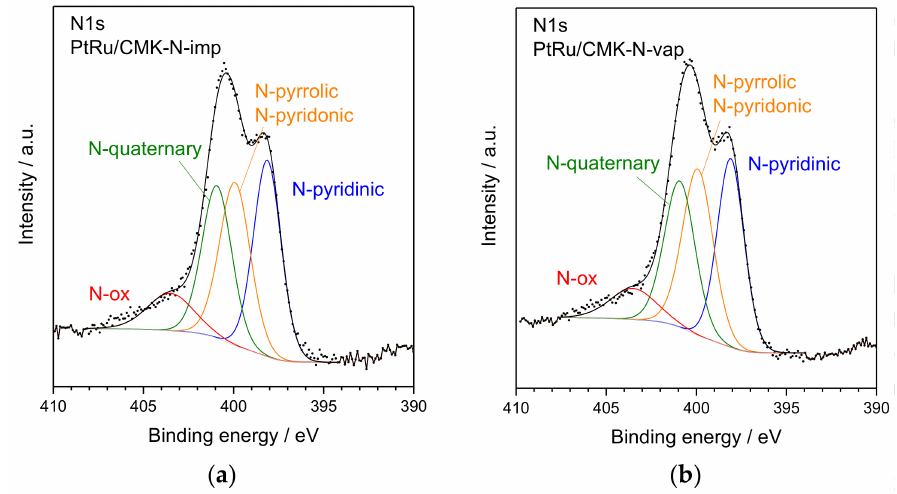
Figure 4. XPS high-resolution N1s spectra of: ( a ) PtRu/CMK-N-imp; ( b ) PtRu/CMK-N-vap. Table 4. Physico-chemical features of N-doped carbon-supported PtRu catalysts from XPS analyses. Species